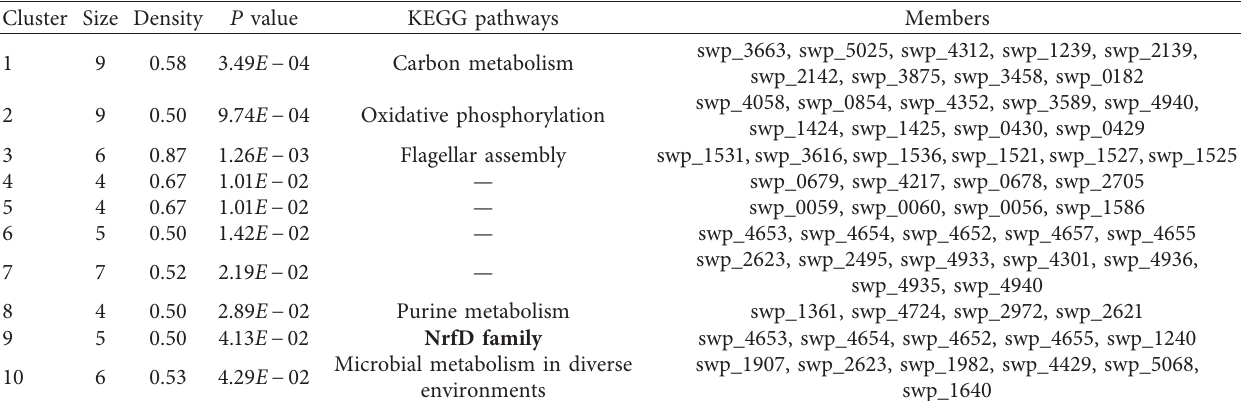
Table 4: The most representative KEGG pathway that was enriched in the modules identified from the high-pressure condition. Cluster Size